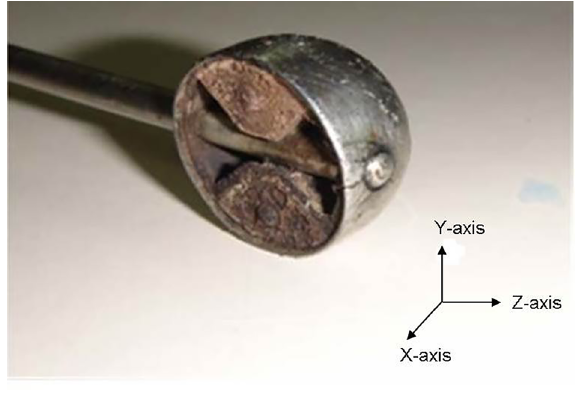
Figure 7. Photograph showing the internal structure of the ovoid of the Henschke